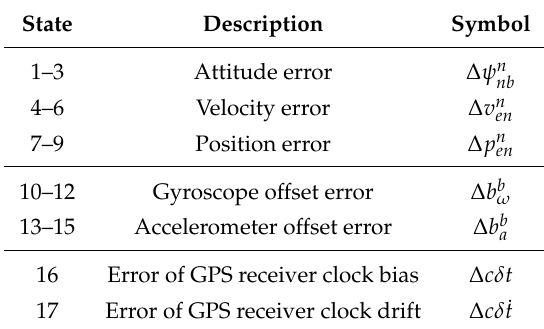
Table 1. State Vector of the Basic